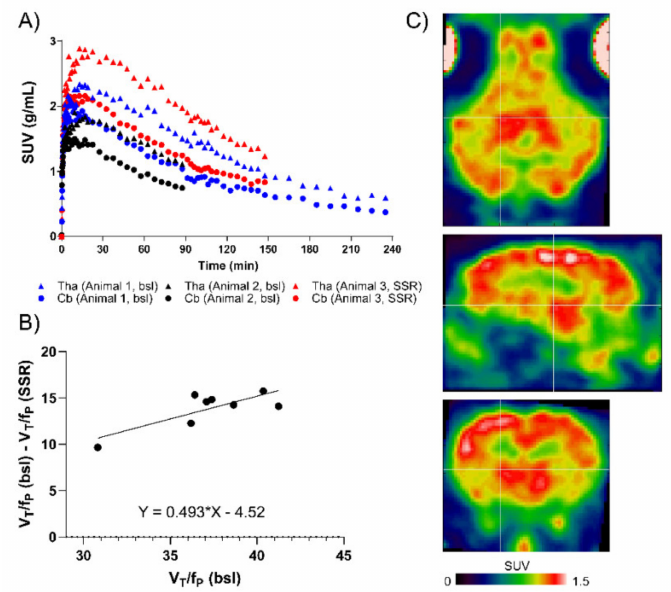
Figure 4. [ 18 F]ASEM binding in the pig brain. ( A ) Time-activity curves of [ 18 F]ASEM in three di ff erent animals: Animal 1, bsl, blue; Animal 2, bsl, black; Animal 3, SSR-180,711 pre-treated, red. The regions shown are: Thalamus (tha, triangles) and cerebellum (cb, circles). ( B ) Lassen plot with total distribution volumes (V T ) corrected for free fraction in plasma (f P ) using values from animal 1 and animal 3. Each point represents one region of interest (ROI), please refer to the method section for the complete list of ROIs. ( C ) Summed PET image (0–240 min) from animal 1 showing the distribution of [ 18 F]ASEM in the pig brain. SUV: standard uptake value. Bsl: baseline. SSR: SSR-180,711 (1 mg /